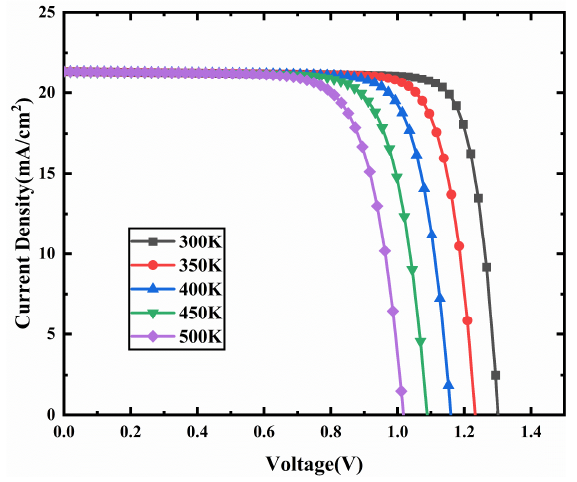
Figure 17. J-V characteristic curves of the device for different operating temperatures.